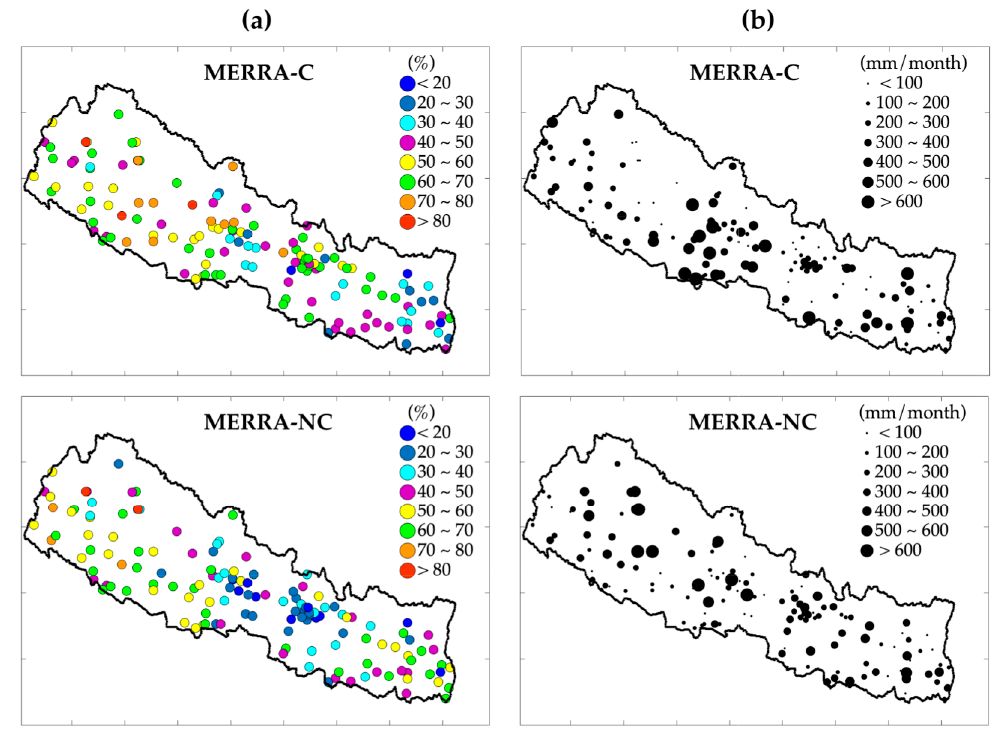
Figure 7. Spatial distribution of ( a ) correlation coefficient (R) and ( b ) RMSE (mm/month) in MERRA- 2 datasets for summer monsoon (JJAS) at each station during the study period.